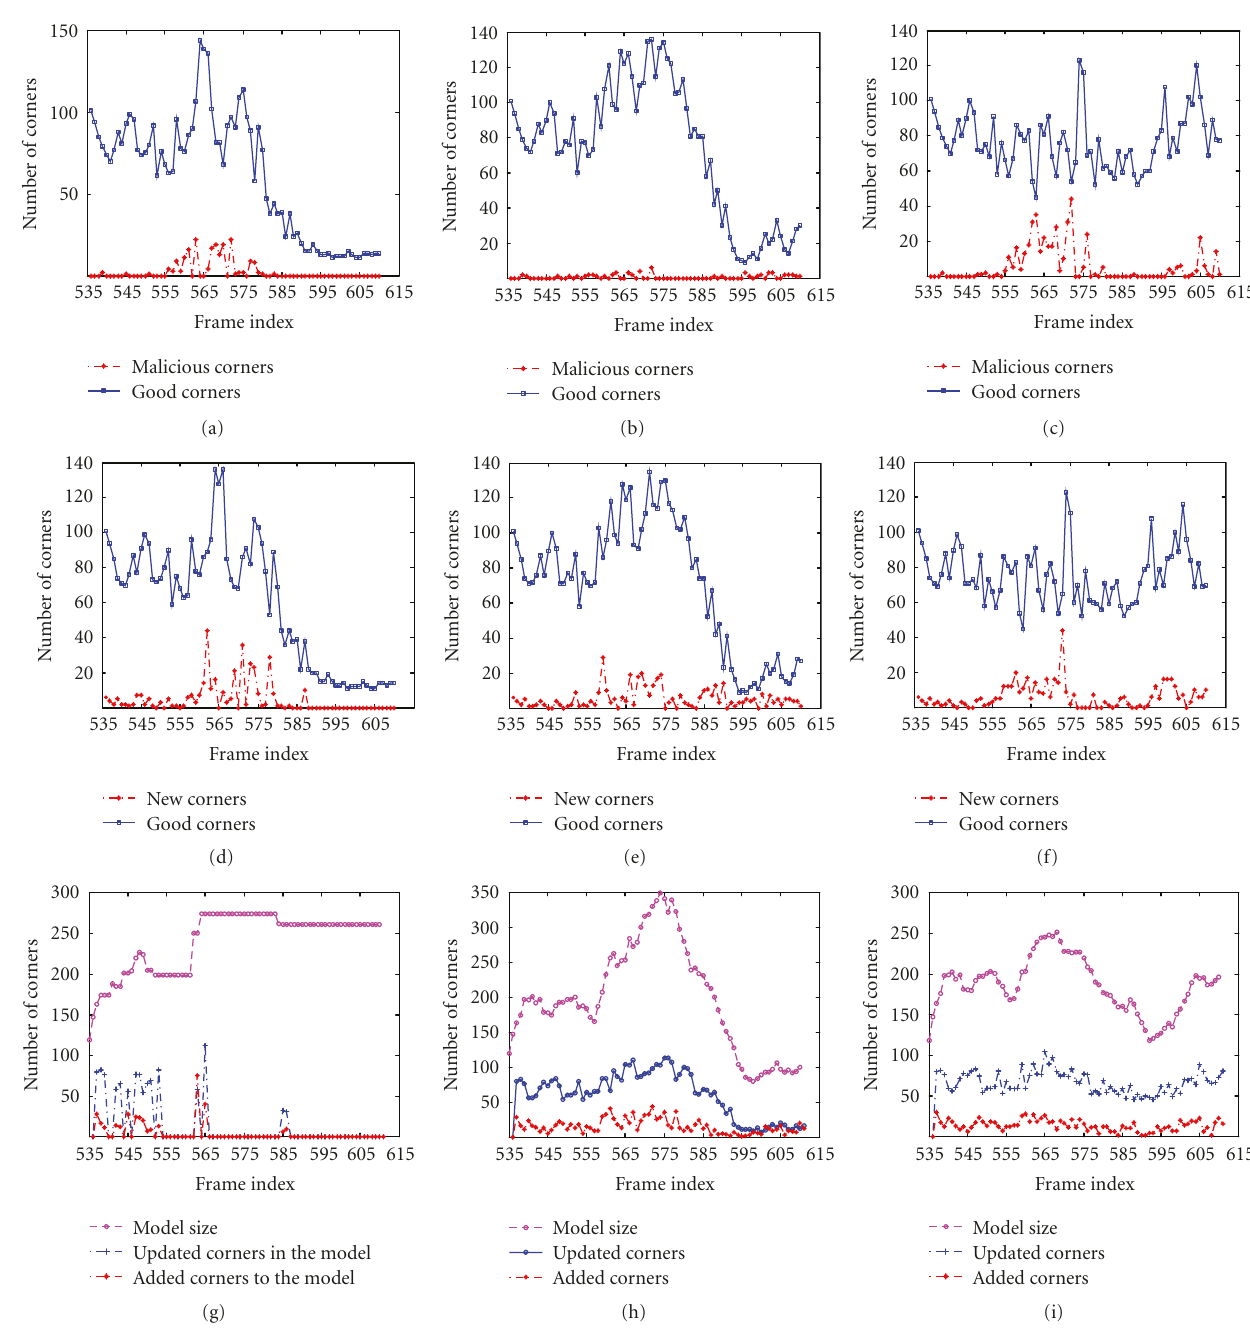
Figure 12: The data statistics regarding the object tracked in Figure 11. Each column corresponds to the same column in Figure 11. First row: number of corners in each class after the first step of classification. Second row: number of corners in each class after the second step of classification. Third row: the model size, the number of associated (updated) corners in the model, and the number of added corners to the model, in each